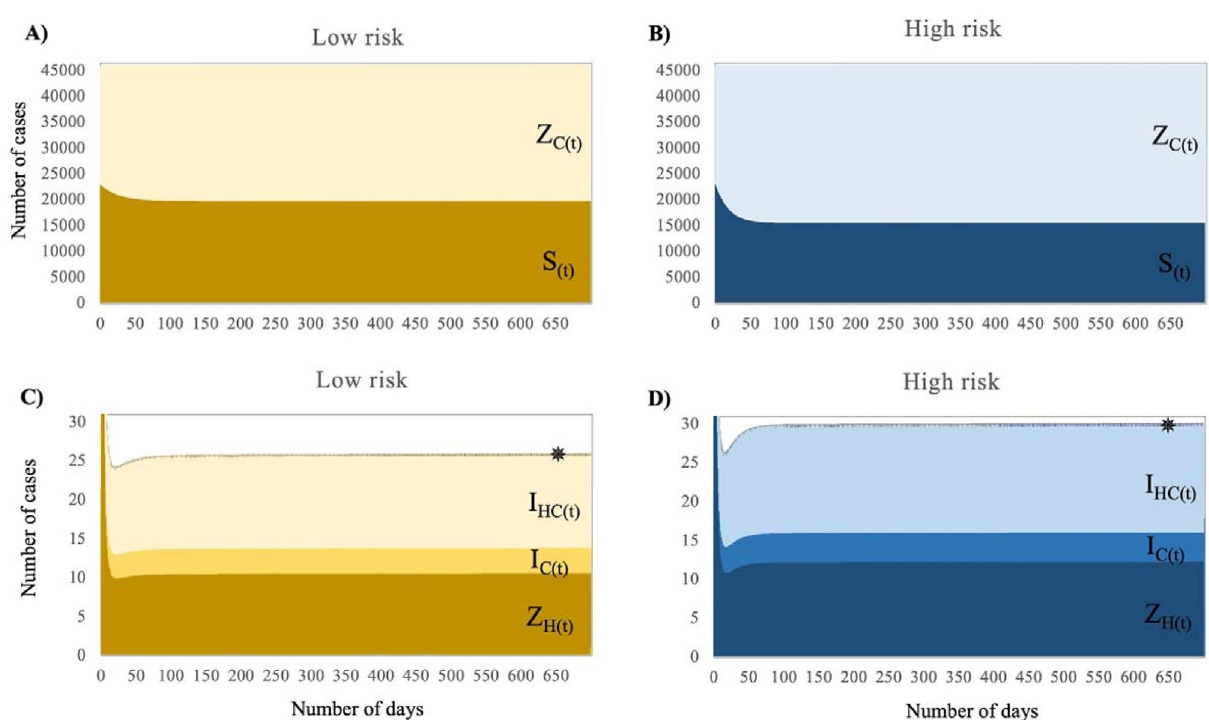
Figure 2. Population dynamics for individuals colonised or infected in the community or the hospital, by risk scenario. Notes: Panels ( A ) and ( B ) show the susceptible and colonised individuals in the community in the low-risk and high-risk scenarios, respectively. Panels ( C ) and ( D ) show individuals colonised at the hospital, or infected in the community or the hospital in the low risk and high-risk scenarios, respectively. ✵ stands for I HH(t). Complete results of the population dynamics by compartment with their respective 95% CIs are presented in the supplementary material, Figs.